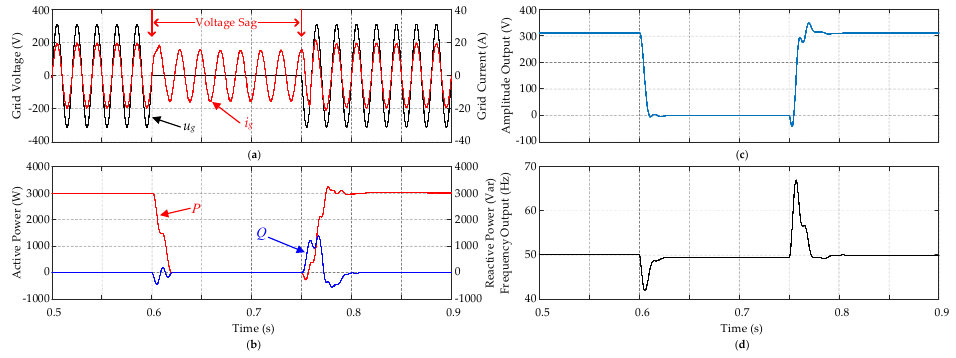
Figure 12. Performance of the PV system with normal SOGI-PLL during ZVRT: ( a ) grid voltage and current; ( b ) active and reactive power; ( c ) amplitude estimation; ( d ) frequency estimation.